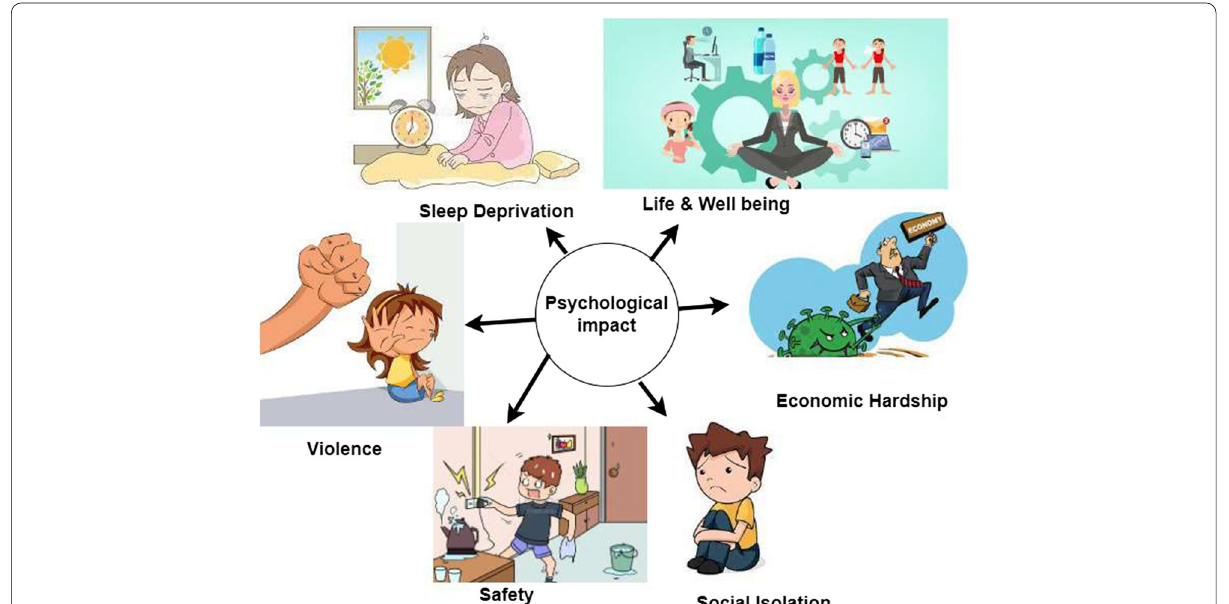
Fig. 4 Psychological impacts of COVID on children, the image was drawn by the